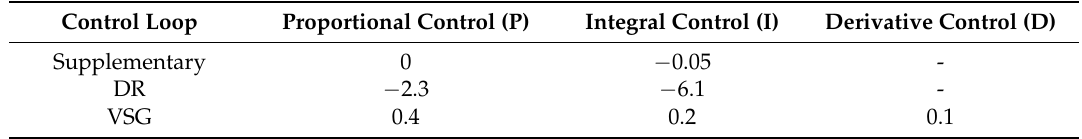
Table A1. Numeric values of control actions used in frequency control loops of the power